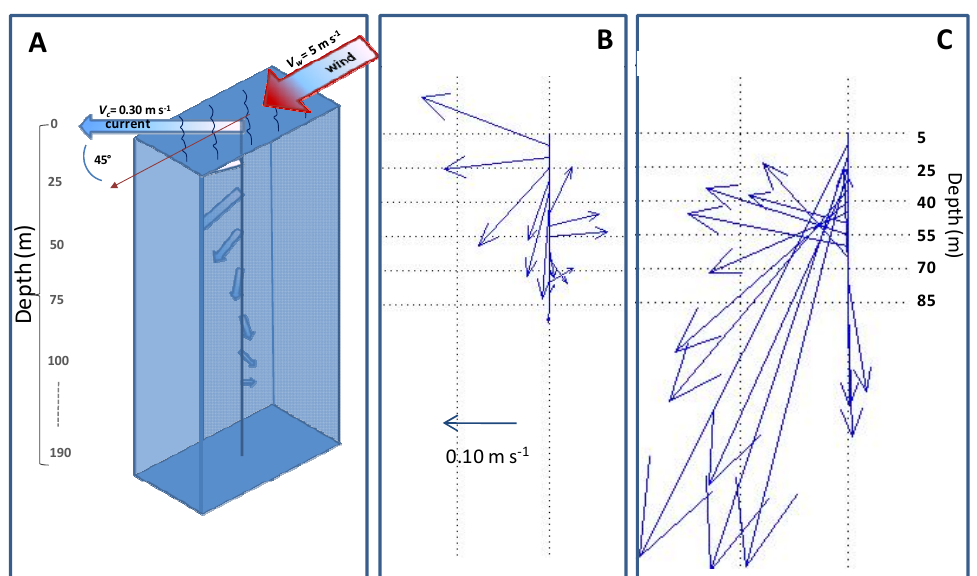
Figure 7. Approximation to a theoretical Ekman spiral from current data gathered at OOCS. In summer 2011 persistent strong S-E surface currents over the thermocline allowed approaching to an idealised Ekman spiral. Although the local currents were not driven by local winds (less than 2 m/s), the current intensities decreased with depth and formed a spiral similar to that of an idealised Ekman spiral. A, the theory suggests that a 5 m/s wind strength will promote a surface current velocity of about 0.30 m/s deviated 45% to the right at the latitude of the station location; B, the surface currents recorded at the station by the ADCP for 9 July 2011; and finally C, for 10 August